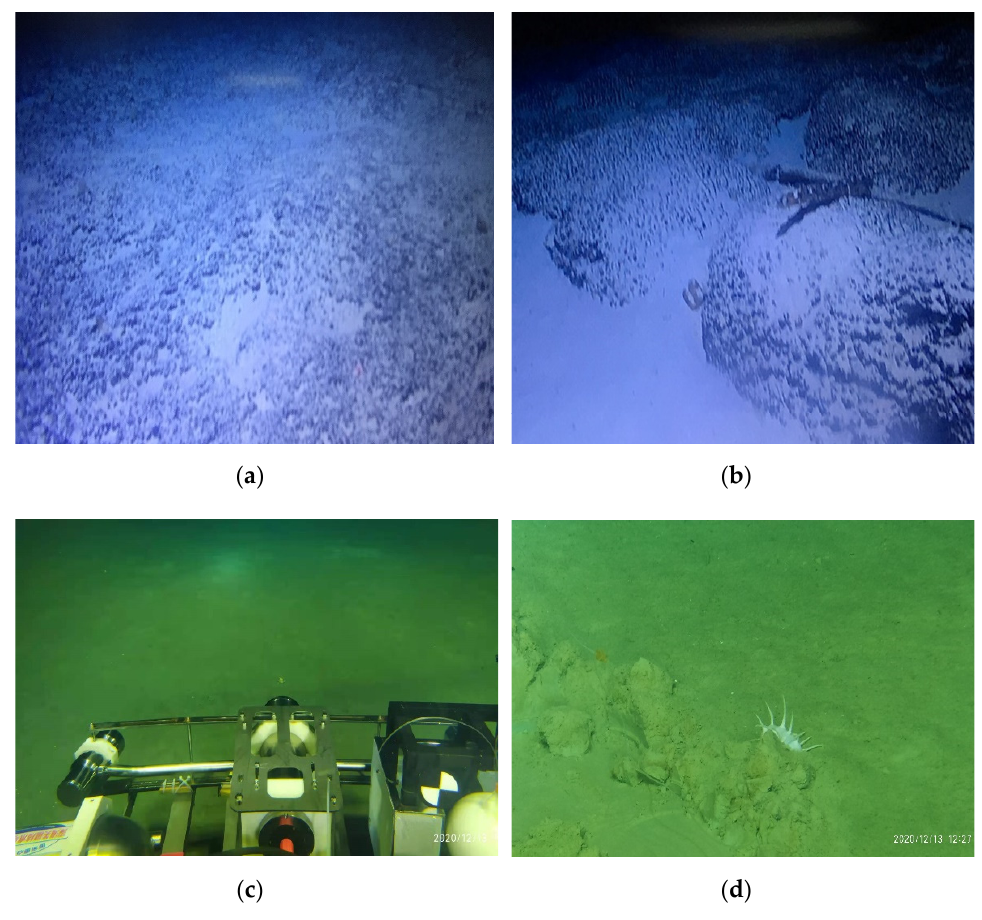
Figure 9. Pictures of ( a , b ) two different kinds of scenarios of the 2019 sea trial that contain FC and NonFC and ( c , d ) scenarios of the 2020 sea trial that contains NonFC from different perspectives.